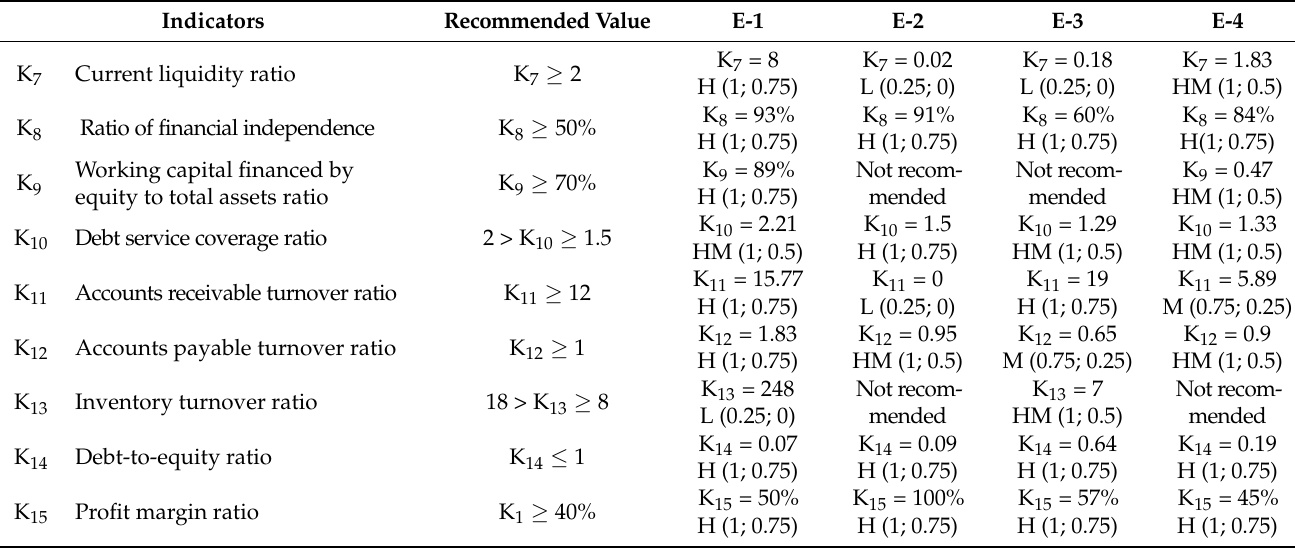
Table 4. Input variables—financial and economic